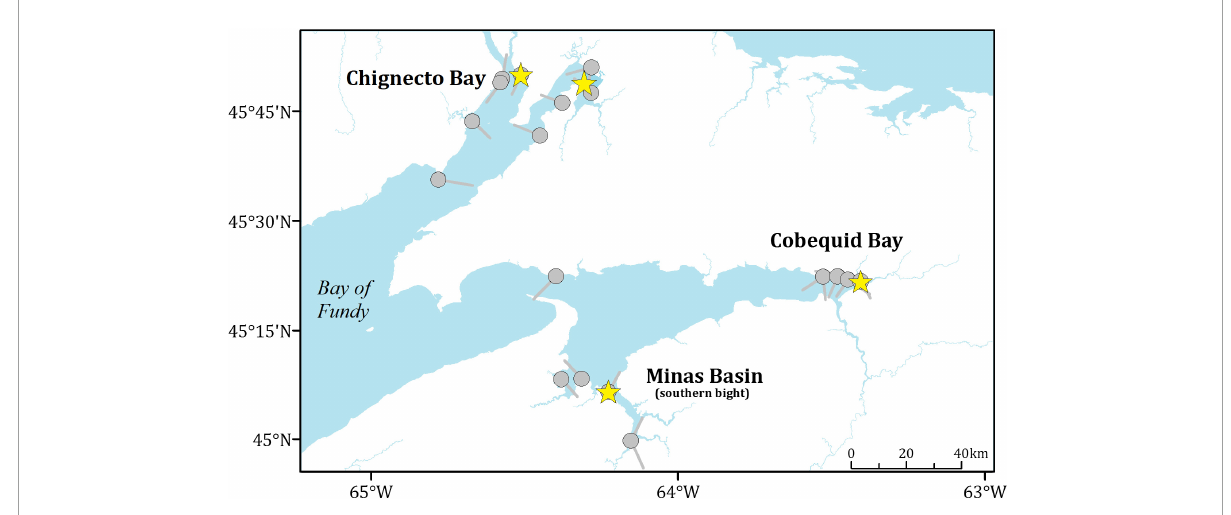
FIGURE1 Map of the upper Bay of Fundy showing the three regions of the bay (Chignecto Bay, Cobequid Bay, and Minas Basin), catch locations (yellow stars), receiver locations and antenna orientations (grey circles and